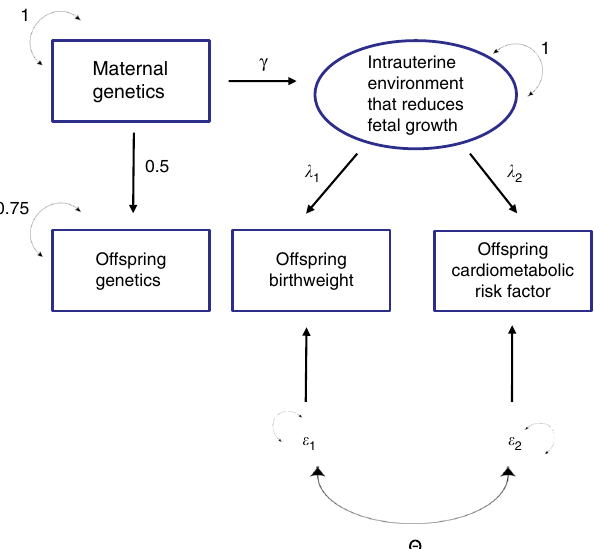
Fig. 2 Path diagram of the relationship between maternal Genetic Risk Score (GRS), offspring GRS, the intrauterine environment, offspring birthweight and an offspring cardiometabolic risk factor. Variables within square boxes represent observed variables, whereas variables in circles represent latent unobserved variables. Unidirectional arrows represent causal relationships from tail to head, whilst two headed arrows represent correlational relationships. Greek letters on one headed arrows represent path coef fi cients which quantify the expected causal effect of one variable on the other. Greek letters on two headed arrows represent covariances between variables. The two epsilon variables represent residual latent factors (both environmental and genetic) that are not modeled in the study. The coef fi cient Θ represents the covariance between the residual terms. We assume that all variables are standardized to have unit variance. Consequently, the residual variance of the offspring GRS is set to 0.75 since ¼ of the variance comes from the maternal genotype. For the purposes of the power calculation described in the discussion, we assume that maternal single nucleotide polymorphism (SNP)s that affect offspring birthweight do so through a single latent intrauterine factor, and that this factor also exerts long term effects on the offspring cardiometabolic risk factor of